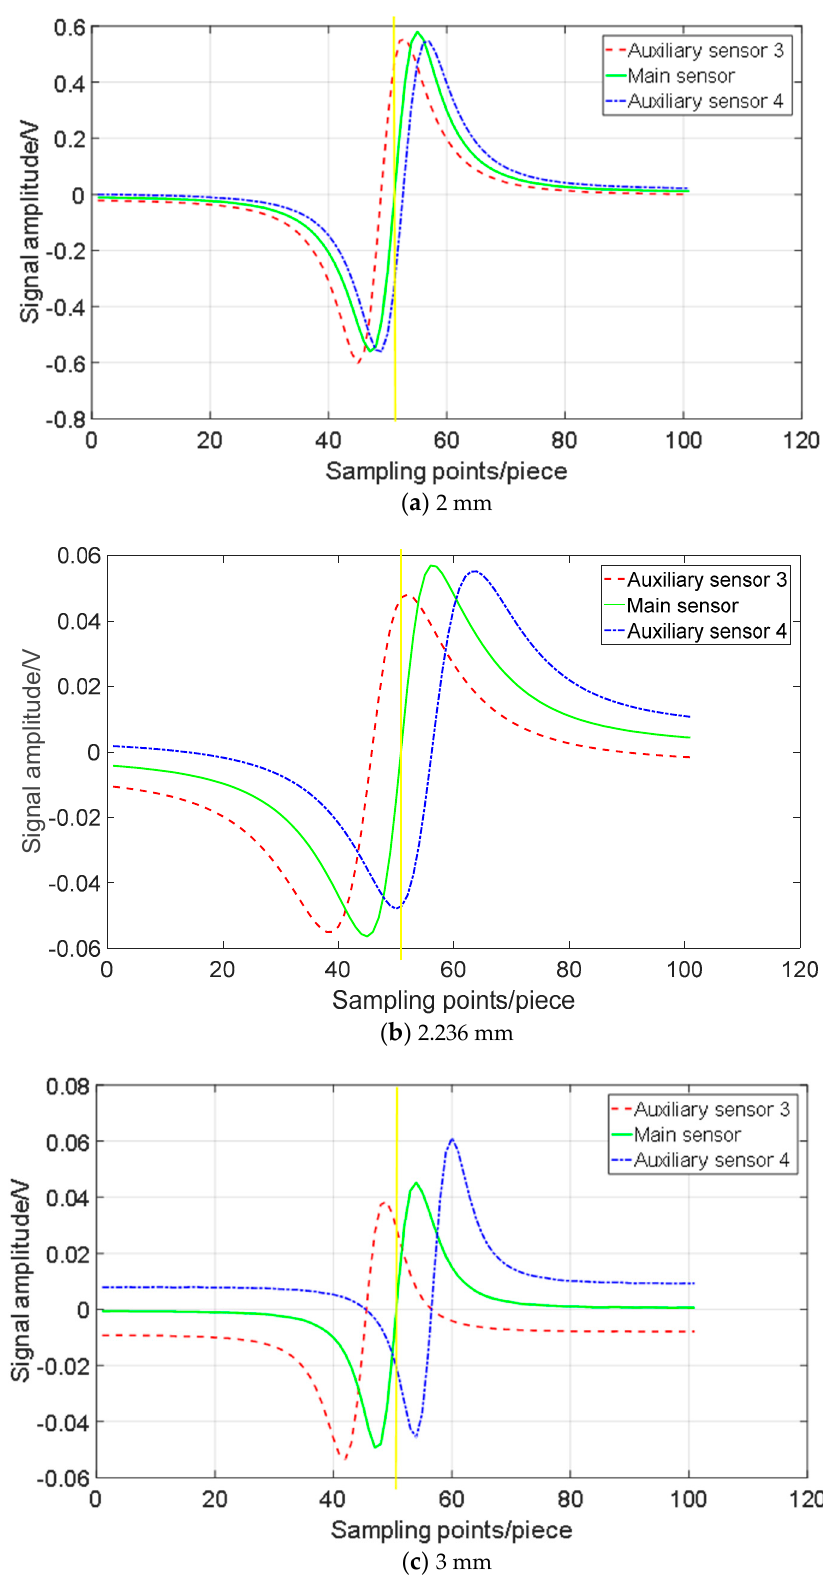
Figure 8. z -component simulation results with different distance.